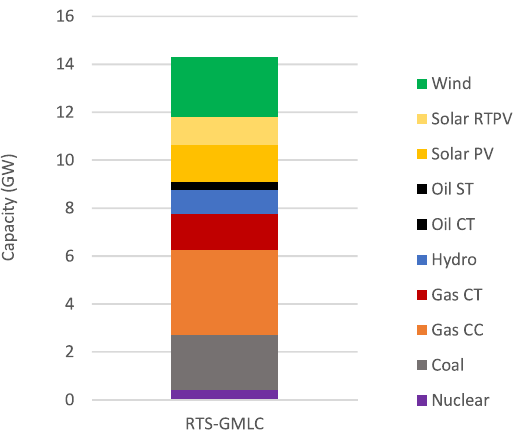
Figure 8. Total electrical capacity in the PLEXOS and Backbone implementations of